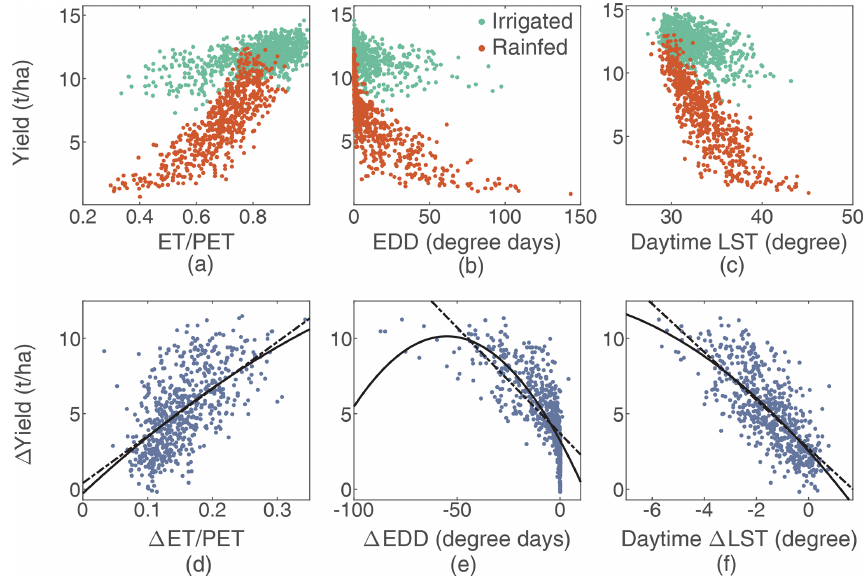
Figure 8. Response of maize yield to ET / PET (a) , EDD (b) , and daytime LST (c) in both irrigated and rainfed maize. Response of yield differences to ET/PET (d) , EDD (e) , and daytime LST (f) differences between irrigated and rainfed maize. The linear (dash black line) and quadratic (solid black line) response curves of (cid:49) Yield to (cid:49) ET / PET, (cid:49) EDD, and (cid:49) LST are shown in (d) – (f) .